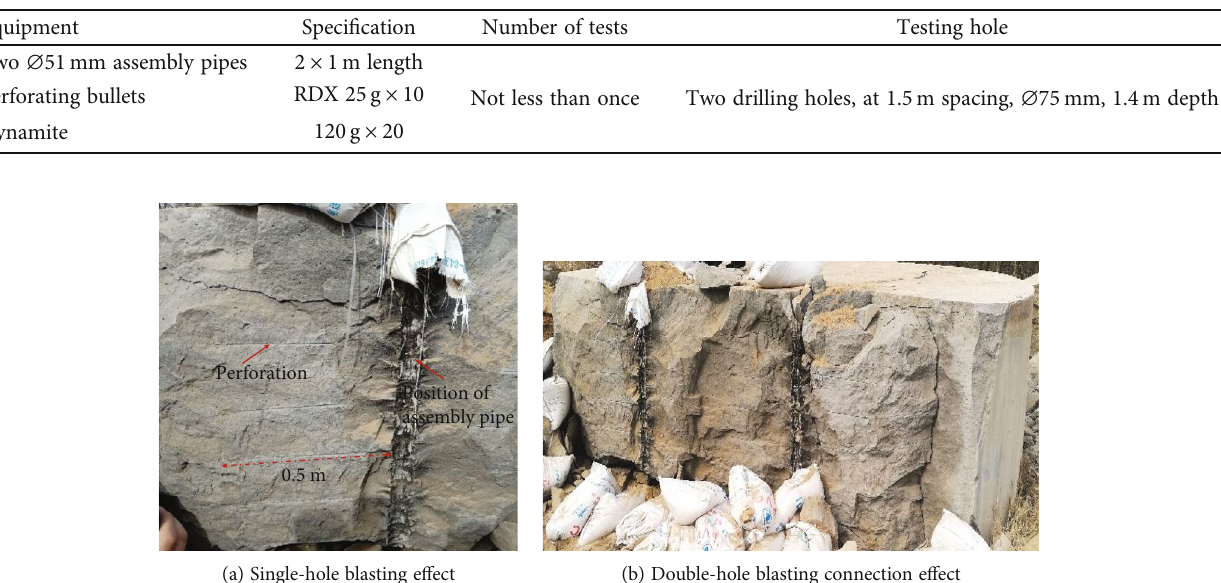
Figure 4: Compound blasting directional crack-forming test. Table 1: Test consumables.